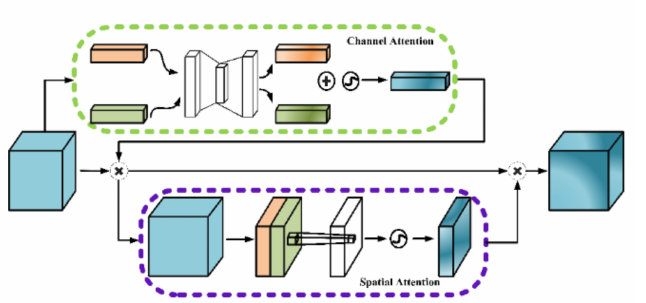
Figure 4. The structure of the Convolutional Block Attention Module. The upper represents the channel attention and the lower represents the spatial attention, the feature maps first pass through the upper and then the